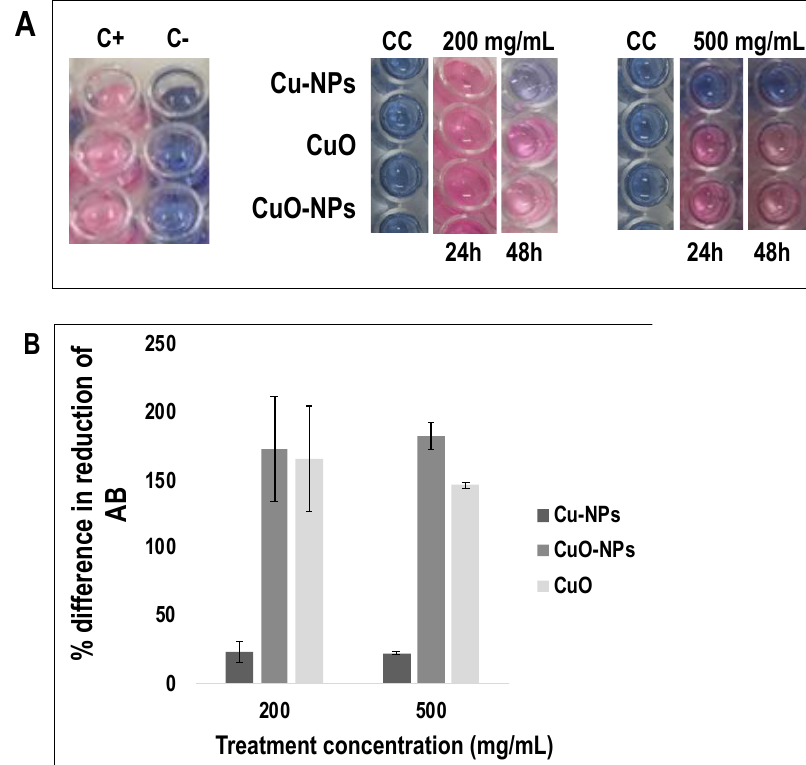
Figure 2. Effects of copper forms on the cell viability of C. gloeosp measured using the Alamar Blue Assay in conjunction with a fluorescence spectrophotometer. Method optimized from the user’s manual (Sigma-Aldrich Co. Inc., Tokyo, Japan). ( A ) Visual color change of the Alamar Blue dye incubated with pathogen spores and various forms of copper (Cu-NPs, CuO-NPs, and CuO) at di ff erent concentrations; C + is the sample control (medium + spores); C − is a reagent control (only medium); and CC is the treatment control (treatment + medium). ( B ) Percent di ff erence in the reduction of Alamar Blue dye between the treated and control spores. The data shown are the mean of three replicates and error bars represent standard deviation.